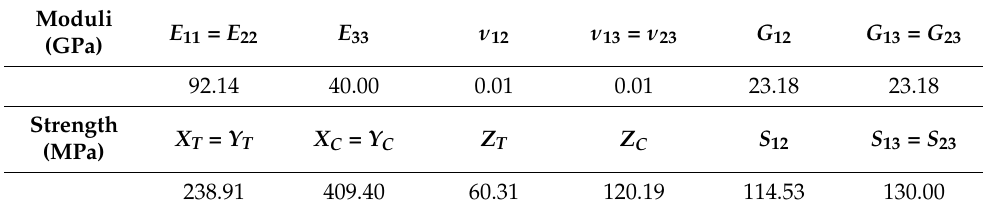
Table 2. Material properties of C/SiC composite.